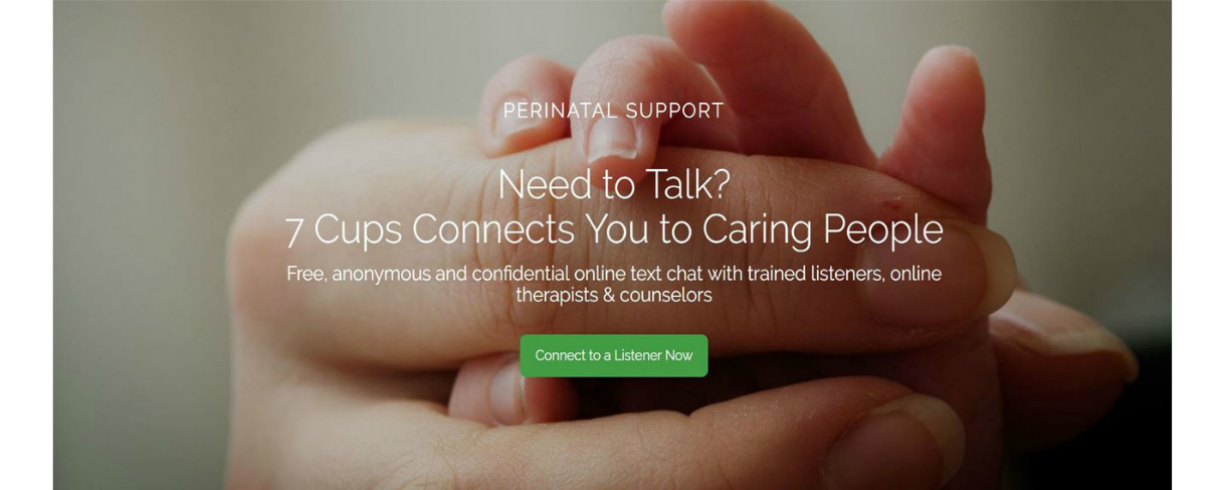
Figure 1. Designated webpage pointing patients to study